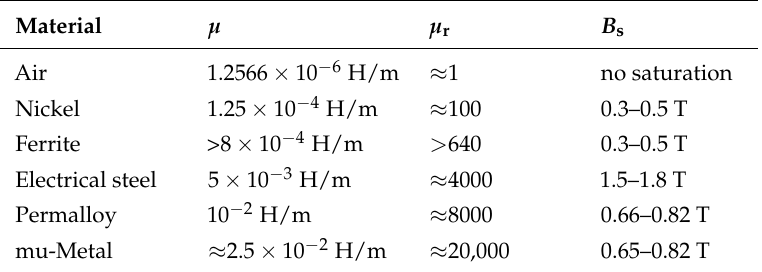
Table 3. Magnetic permeability µ in Henries per meter, relative permeability µ r and saturation flux density B s in tesla for different materials. For µ and µ r the initial permeability of the respective core material is given in the table [16,19,20].